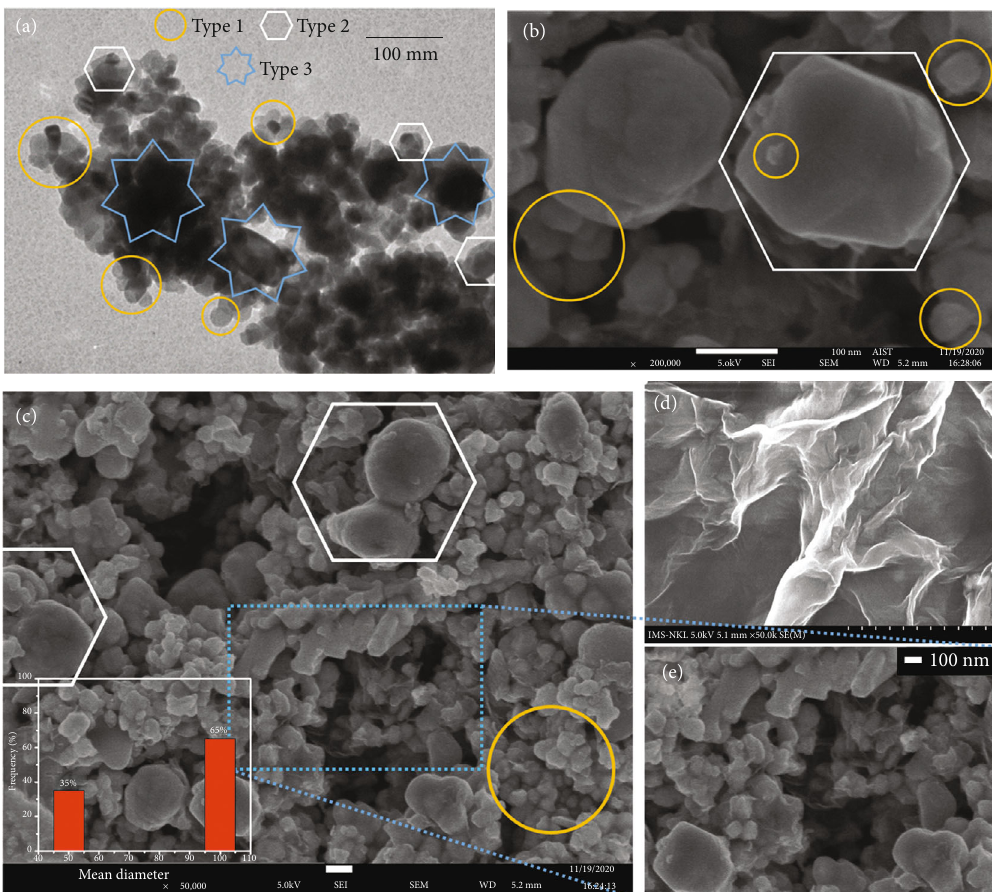
Figure 1: TEM image of (a) Ag/TiO /GO, (b, c, e) SEM images with di ff erent magni fi cation and particle size distribution histograms of 2 Ag/TiO /GO, and (d) 2